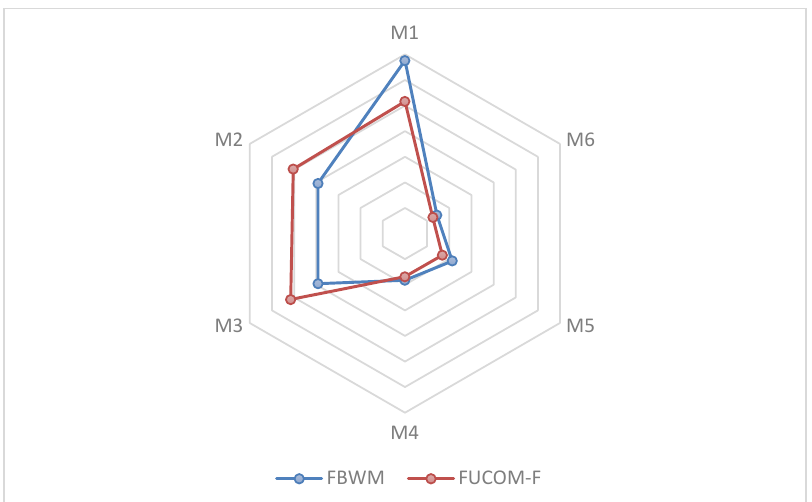
Fig. 2. Weight Values Comparison between FBWM and